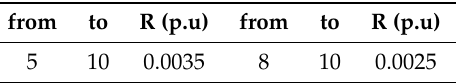
Table 1. Proposed connections for testing the mesh grid case in the 10-bus test system.